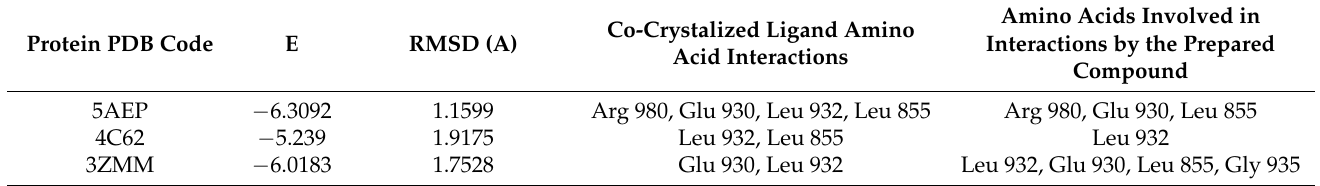
Table 1. Binding affinities and RMSD scores in addition to the amino acid interactions of compound 3 at three target JAK2 kinase proteins (PDB: 5AEP, 4C62, and 3ZMM).